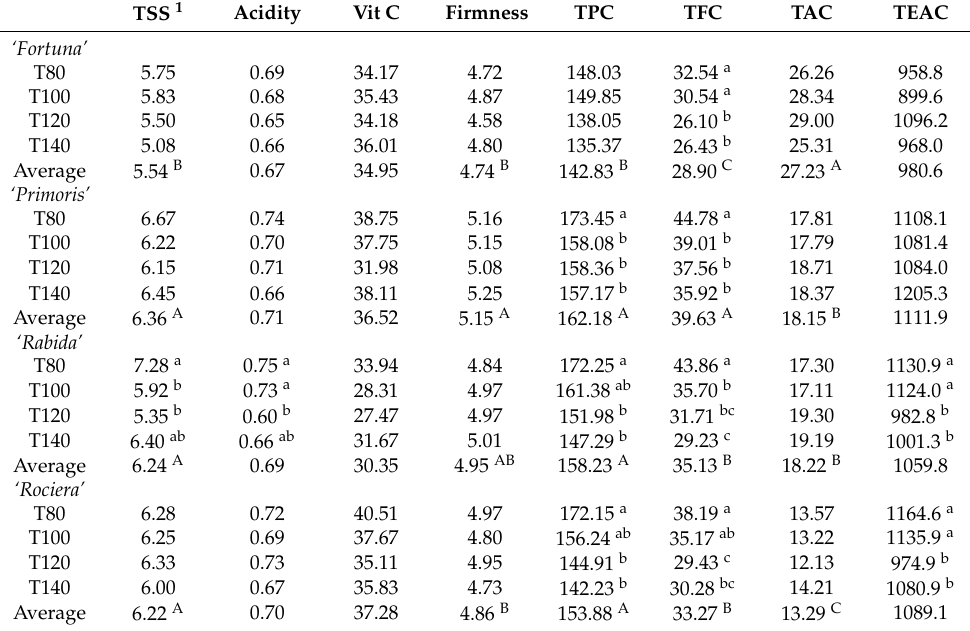
Table 4. Mean values ( n = 9) of the organoleptic and functional fruit quality parameters in the four strawberry cultivars under the different water treatments supplied in the 2017–2018 cropping season. Each value is the mean of the two sampling dates (08 March 2018 and 5 April 2018). Within a cultivar, different superscript letters indicate significant ( p < 0.05) differences between water